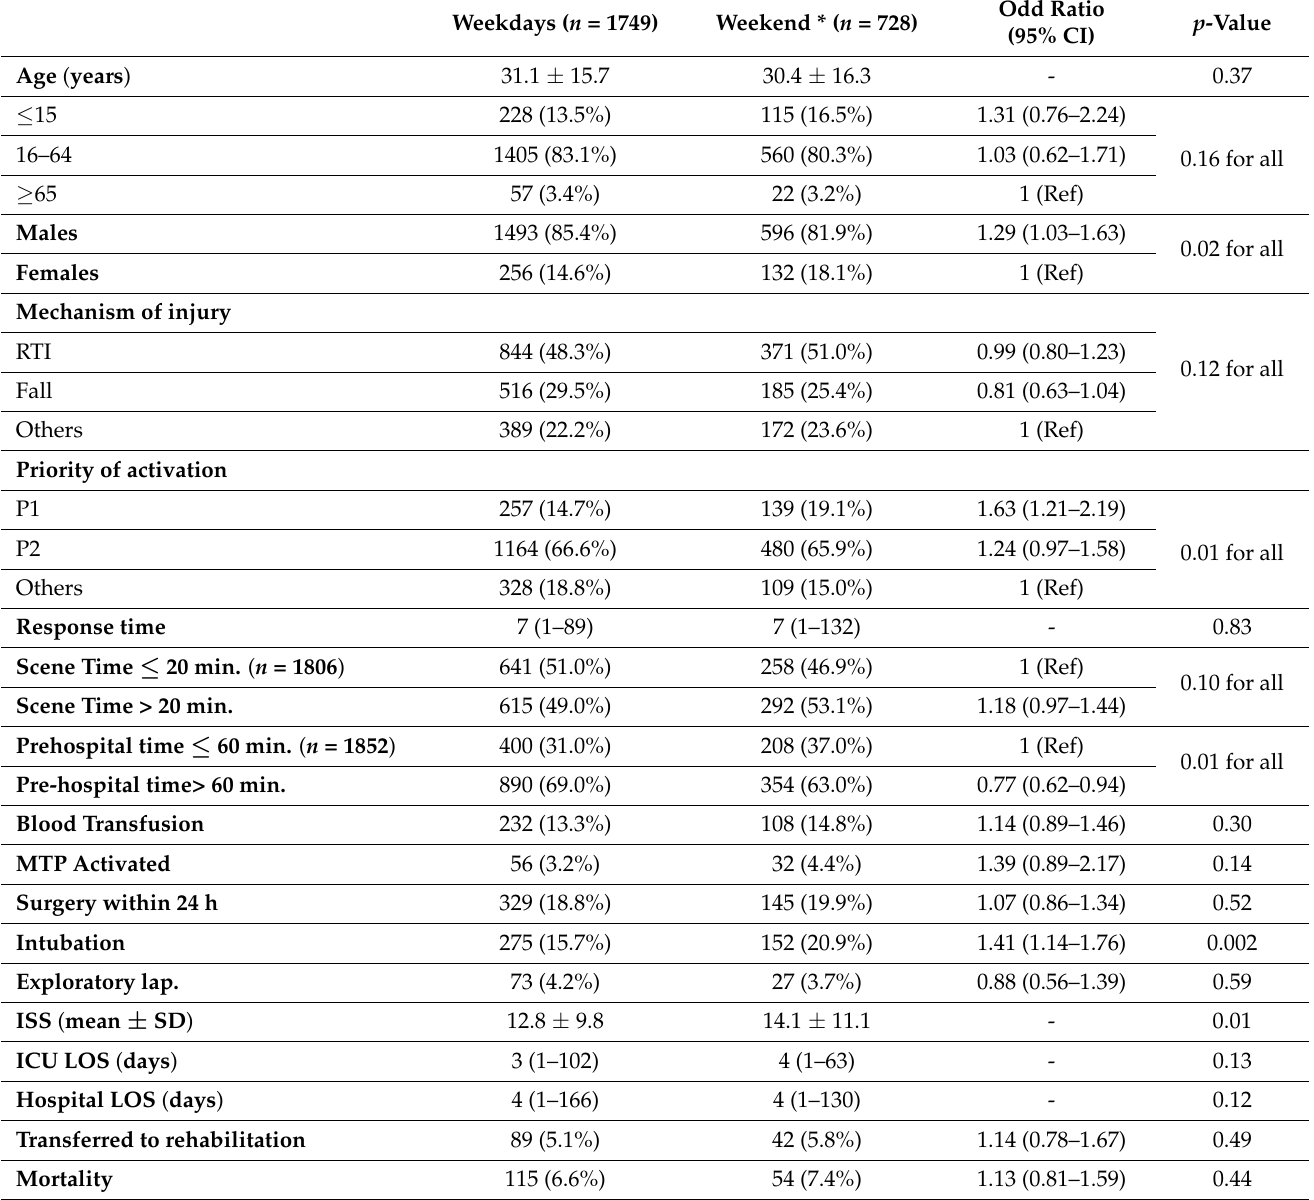
Table 2. Comparison of demographics and outcome by day of the